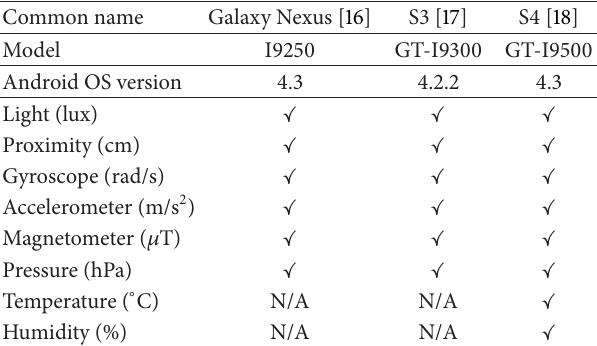
Table 1: List of smartphone models used and their available